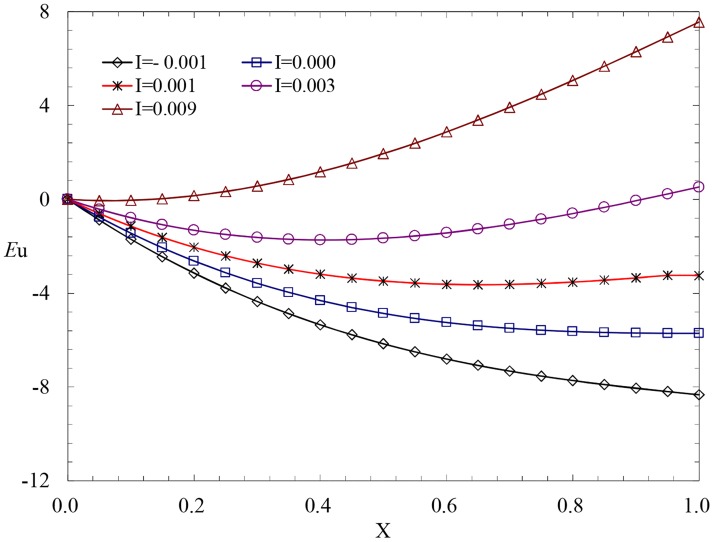
Effects of the slope on the pressure profiles.